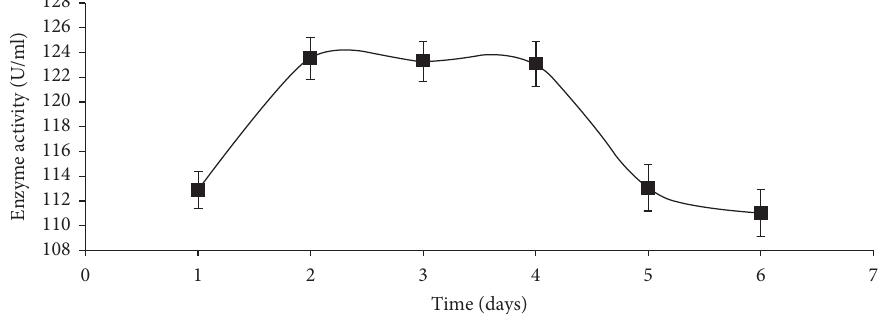
Figure 2: Effect of incubation time on dextranase production from Talaromyces sp.